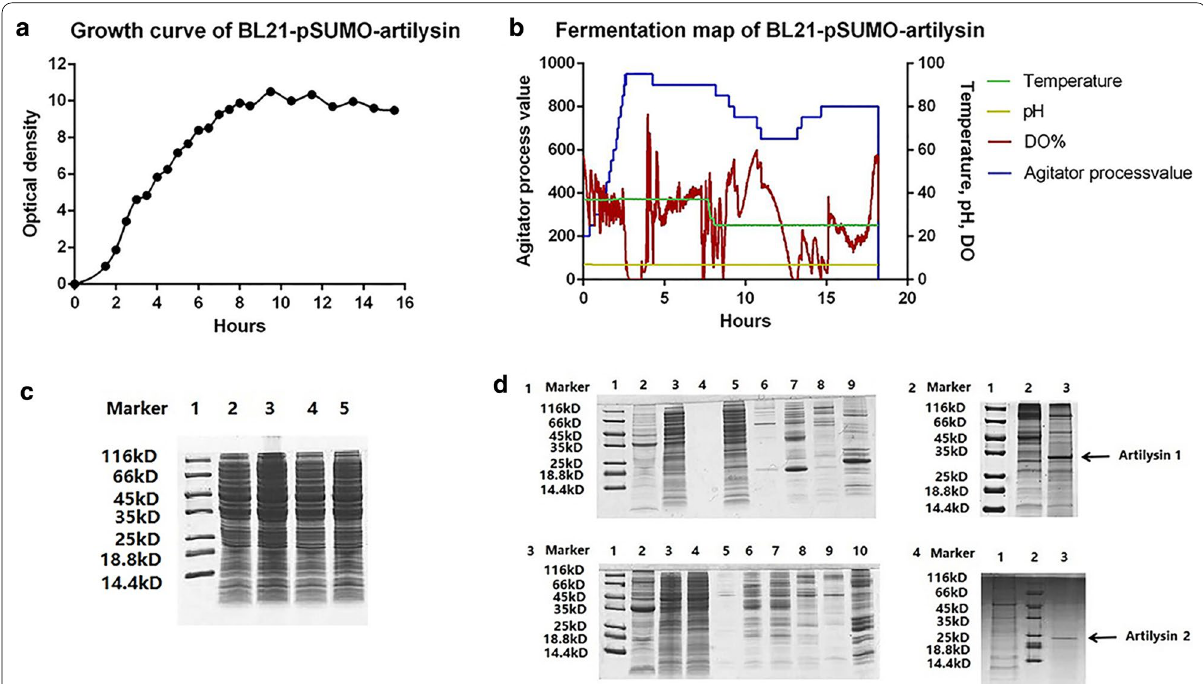
Fig. 3 E. coli expression system using BL21-pSUMO-artilysin engineered bacteria for protein production and purification. a The growth curve for BL21-pSUMO-artilysin at 37 ℃ . b Fermentation map following high-density fermentation in a 5-l fermenter. c SDS-PAGE gel of BL21-pSUMO-artilysin before and after the addition of isopropyl β-d-1-thiogalactopyranoside. 1: Marker; 2: BL21-pSUMO-artilysin1 bacteria before induction; 3: BL21-pSUMO-artilysin1 bacteria after induction; 4: BL21-pSUMO-artilysin2 bacteria before induction; 5: BL21-pSUMO-artilysin2 bacteria after induction. d SDS-PAGE gels (1 and 3) of the collected eluates. The later peak contains fewer impurities, and the target protein purity is greater. (1) 1: Marker; 2: Precipitate after lysis of BL21-pSUMO-artilysin1 bacteria; 3: Supernatant after lysis of BL21-pSUMO-artilysin1 bacteria; 4: Blank; 5: Flowthrough; 6: Postpeak of elution; 7: Middle peak of elution; 8: Prepeak of elution; 9: Alkaline wash. (3) 1: Marker; 2: Precipitate after lysis of BL21-pSUMO-artilysin2 bacteria; 3: Supernatant after lysis of BL21-pSUMO-artilysin2 bacteria; 4: Flowthrough; 5: Prepeak of elution; 6: Middle peak of elution-1; 7: Middle peak of elution-2; 8: Middle peak of elution-3; 9: Postpeak of elution; 10: Alkaline wash. SUMO enzyme was used to digest the EP-LP, thus producing artilysins. SDS-PAGE protein gels (2 and 4) showing artilysins after preliminary purification. (2) 1: Marker; 2: SUMO-artilysin1; 3: artilysin 1. (4) 1: Marker; 2: SUMO-artilysin2; 3: artilysin